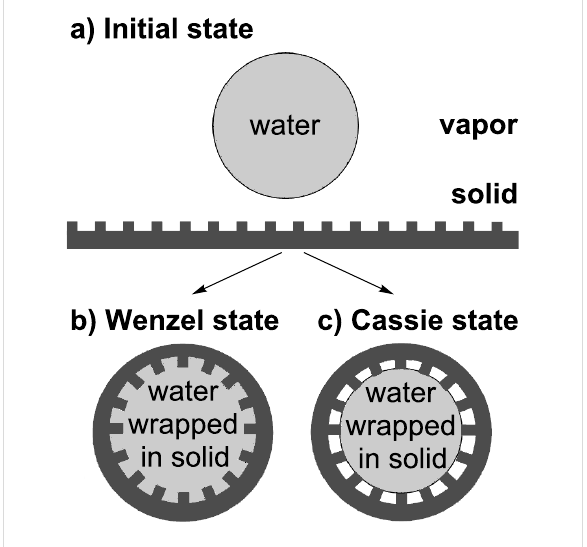
Figure 3: Initial and final states involved in a droplet wrapping event for a flexible ribbon membrane with rigid roughness. In the Wenzel case the liquid penetrates between features and in the Cassie case it bridges between